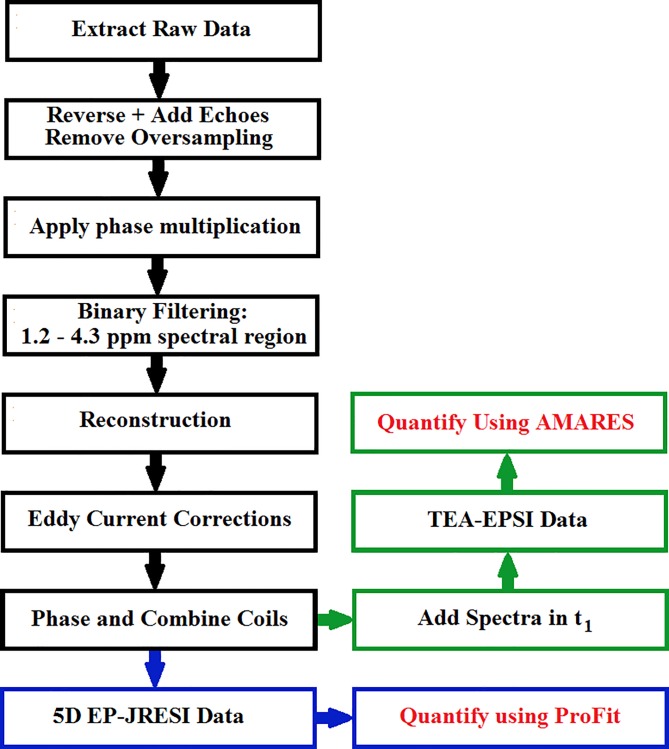
A diagram detailing the post-processing pipeline is displayed.The final results for the 5D EP-JRESI are highlighted in blue and the final results for the TEA-EPSI are highlighted in green. Red text is used to show the two quantitation methods.